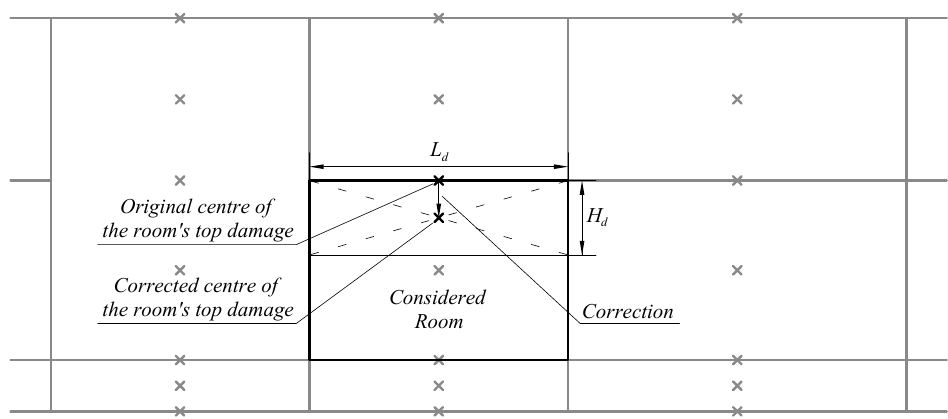
Figure 4. Correction of the vertical position of the damage center according to the damage area for a top